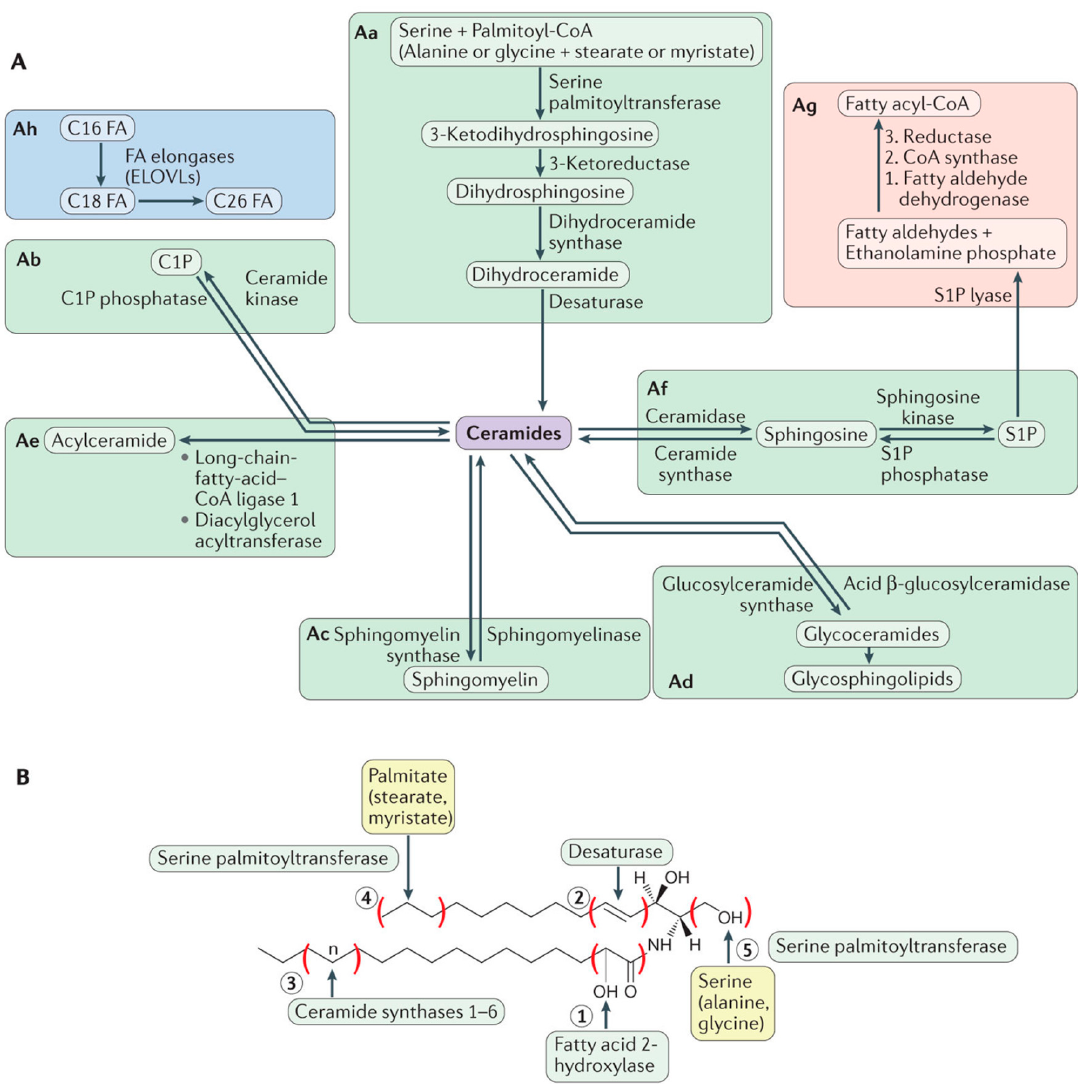
Figure 2. Overview of sphingolipid metabolism. Being the precursors of all complex sphingolipids, ceramides constitute a family of closely related molecules that contain a sphingoid base and an amino-linked fatty acid. Ceramide can be generated through different pathways but most of them can also operate in reverse and use ceramide to produce other metabolic products ( A ). In addition, different enzymes may introduce variations to the basic structure, increasing variability ( B ). From Hannun and Obeid [28].